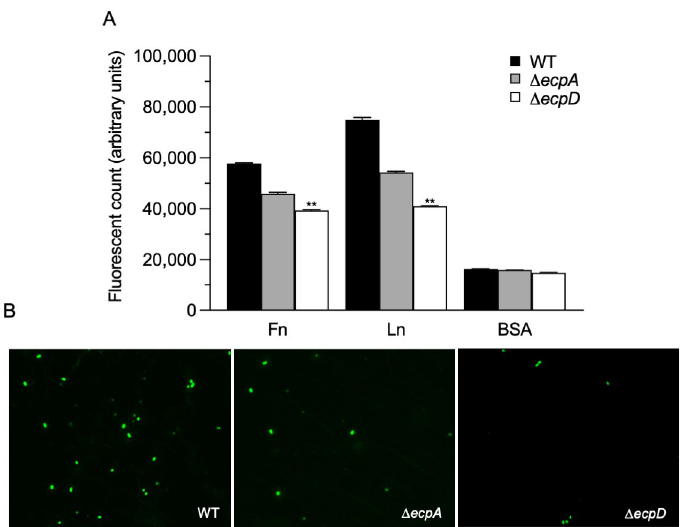
Figure 2. EPEC ECP-mediated binding to Fn and Ln. ( A ) A fluorescence emitter was used to quantify the binding of EPEC E2348/69 and their ∆ ecpA and ∆ ecpD isogenic mutants to ECM glycoproteins. Fluorescence levels were read at an OD of 595 nm. BSA was used as a negative control. ( B ) Binding of Fn with EPEC strains (green) was performed by means of immunofluorescence using anti-O127 antibodies and anti-rabbit Alexa Fluor 488. Immunofluorescence images were taken at 60×. Quantitative data shown represent the mean of three experiments performed in triplicate on different days (Kruskal–Wallis test, ** p < 0.01).